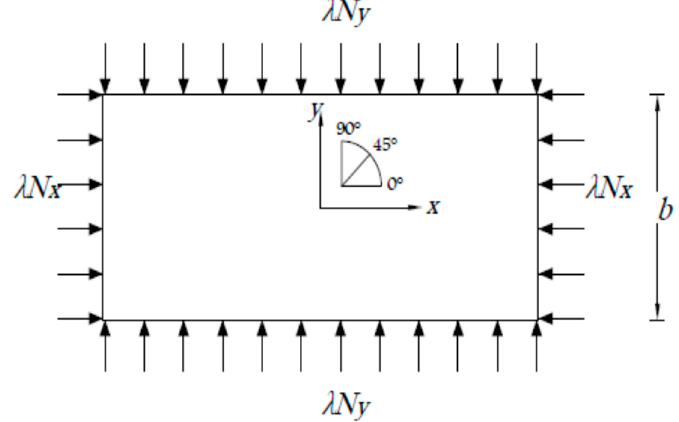
Figure 2. Simply supported plate subjected to biaxial loading.